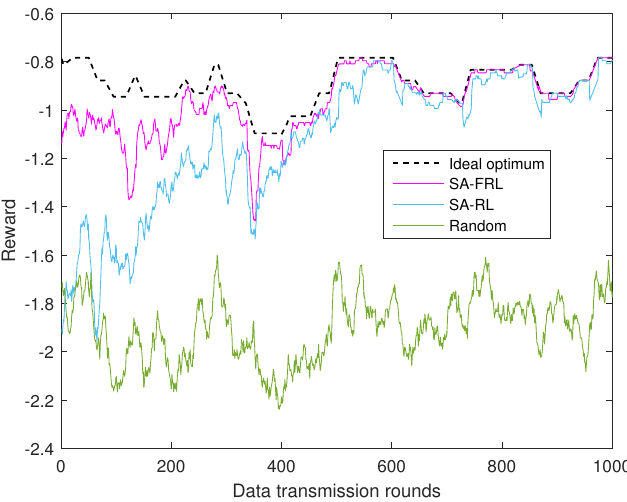
Figure 12. Performance convergence of reward, experimental data.